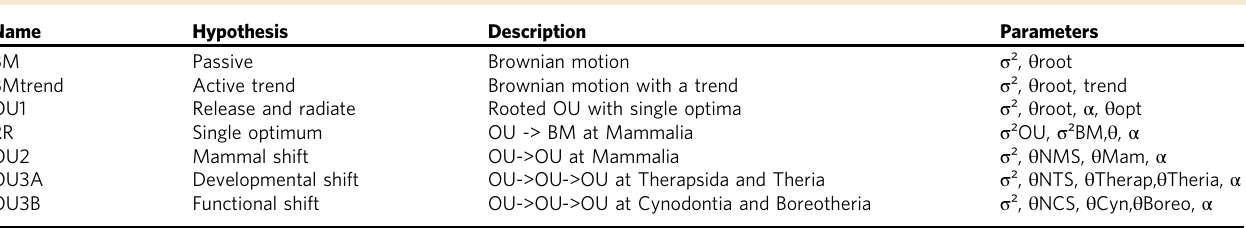
Table 1:RR); (5) Mammal shift, which invokes an OU model with a single regime shift at Mammalia associated with the origin of the crown group (Figs. 1e, 2, Table 1: OU2); (6) Developmental shift, which tests if complexity is constrained by the number of